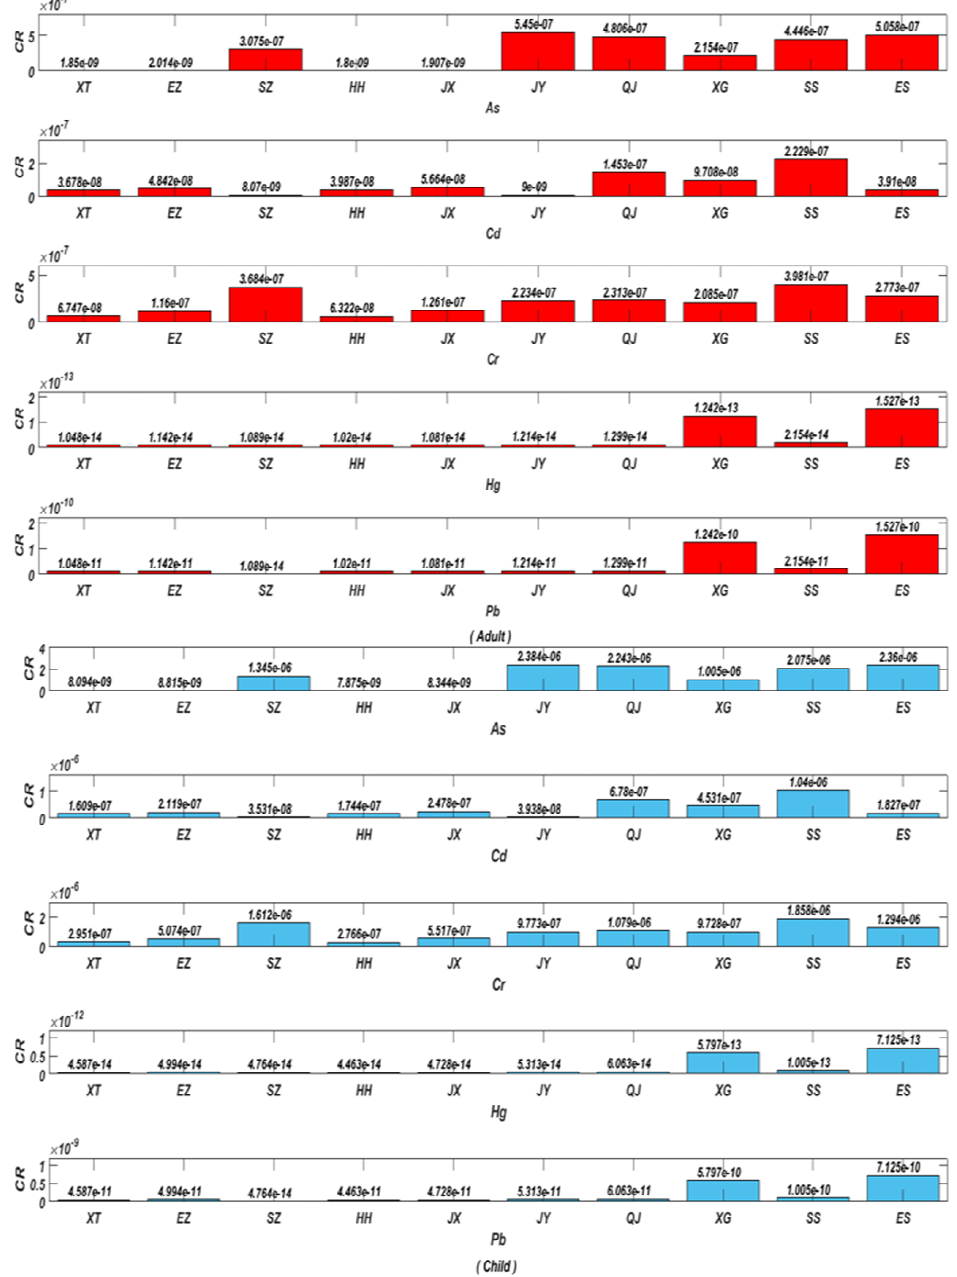
Figure 8. Carcinogenic risk (CR) of heavy metals for different age consumers in the abdominal muscles of crayfish.